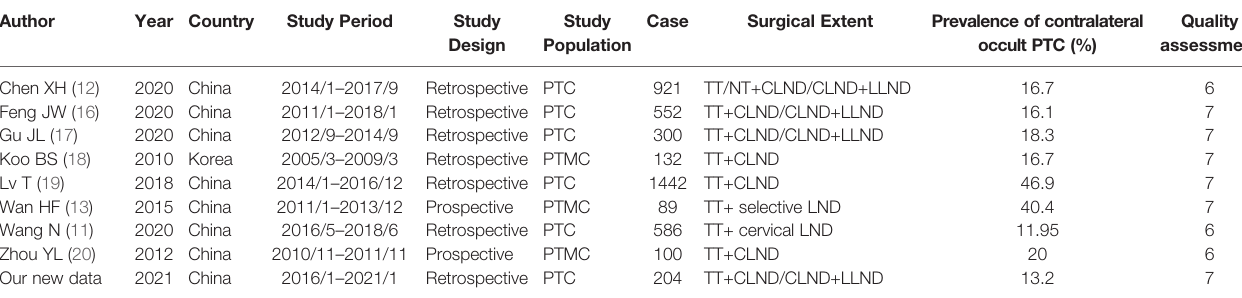
TABLE 2 | Characteristics of the nine included